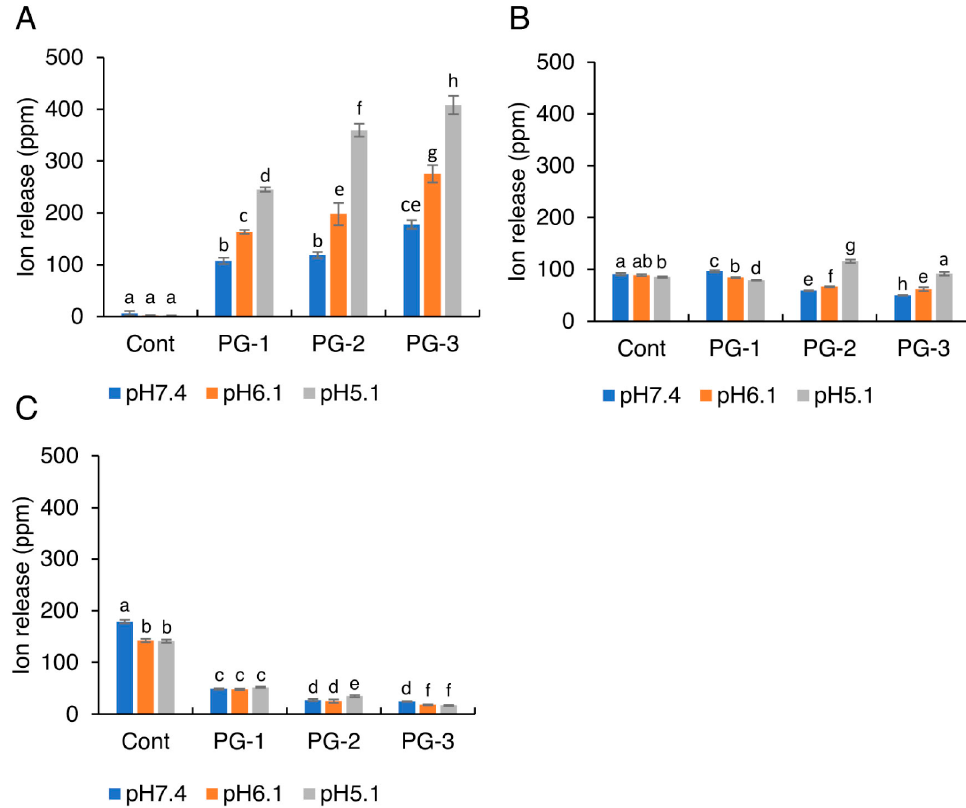
Figure 5. The concentrations of ( A ) Zn 2+ , ( B ) SiO 32 − , and ( C ) F − released from the glass particles into the pH-adjusted BHI broth. Bars represent the standard deviations of the six replicates. a – h: letters indicate significant differences ( p < 0.05, ANOVA, Tukey’s HSD test).